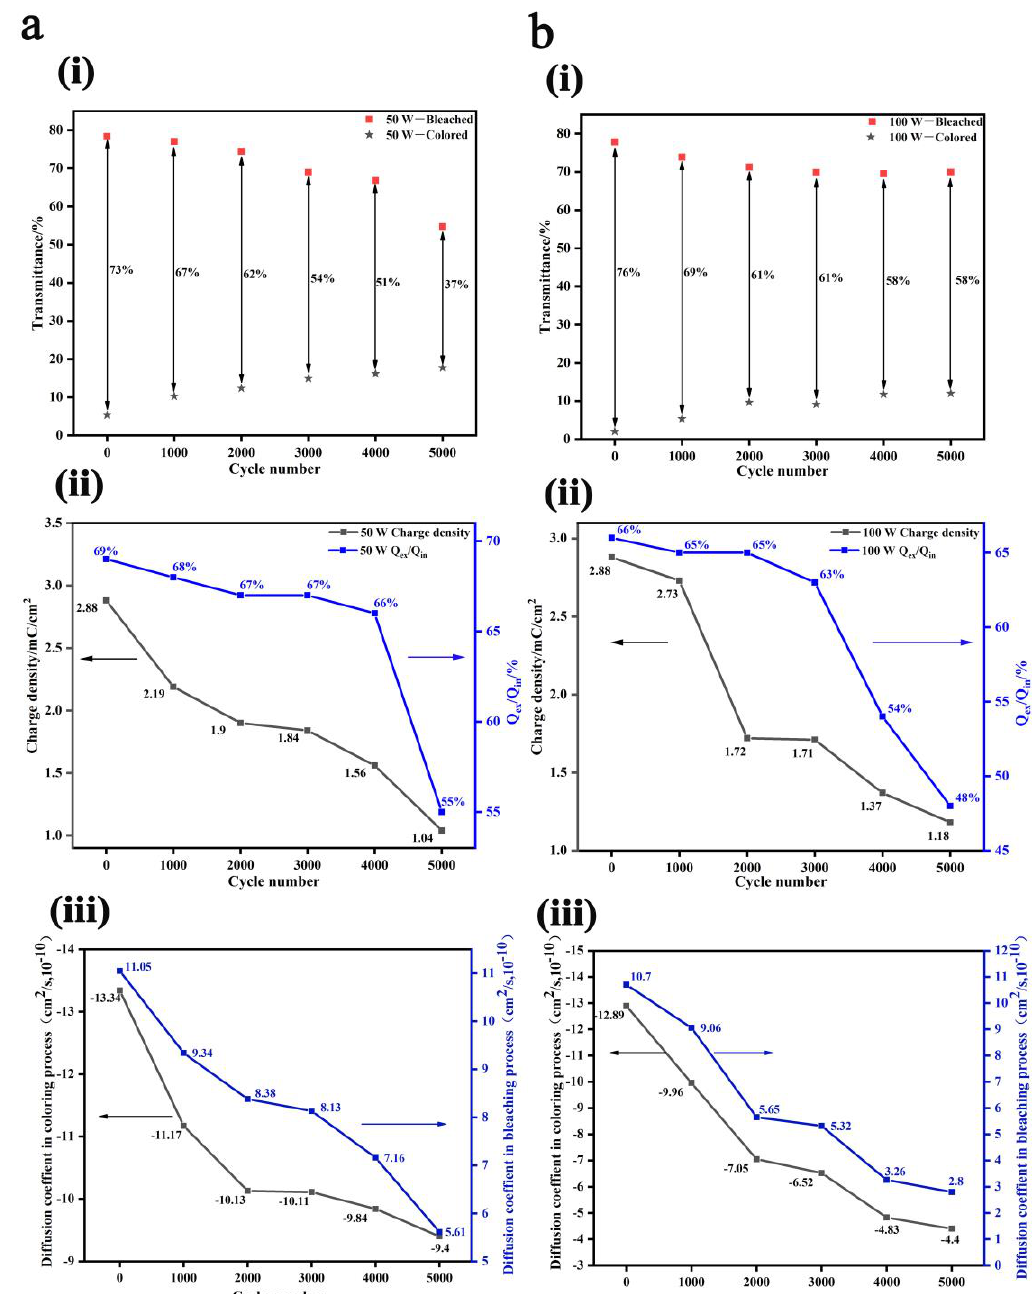
Figure 3. Electrochemical performances of the WO 3 films during 5000 cyclic voltammetry (CV) cy-